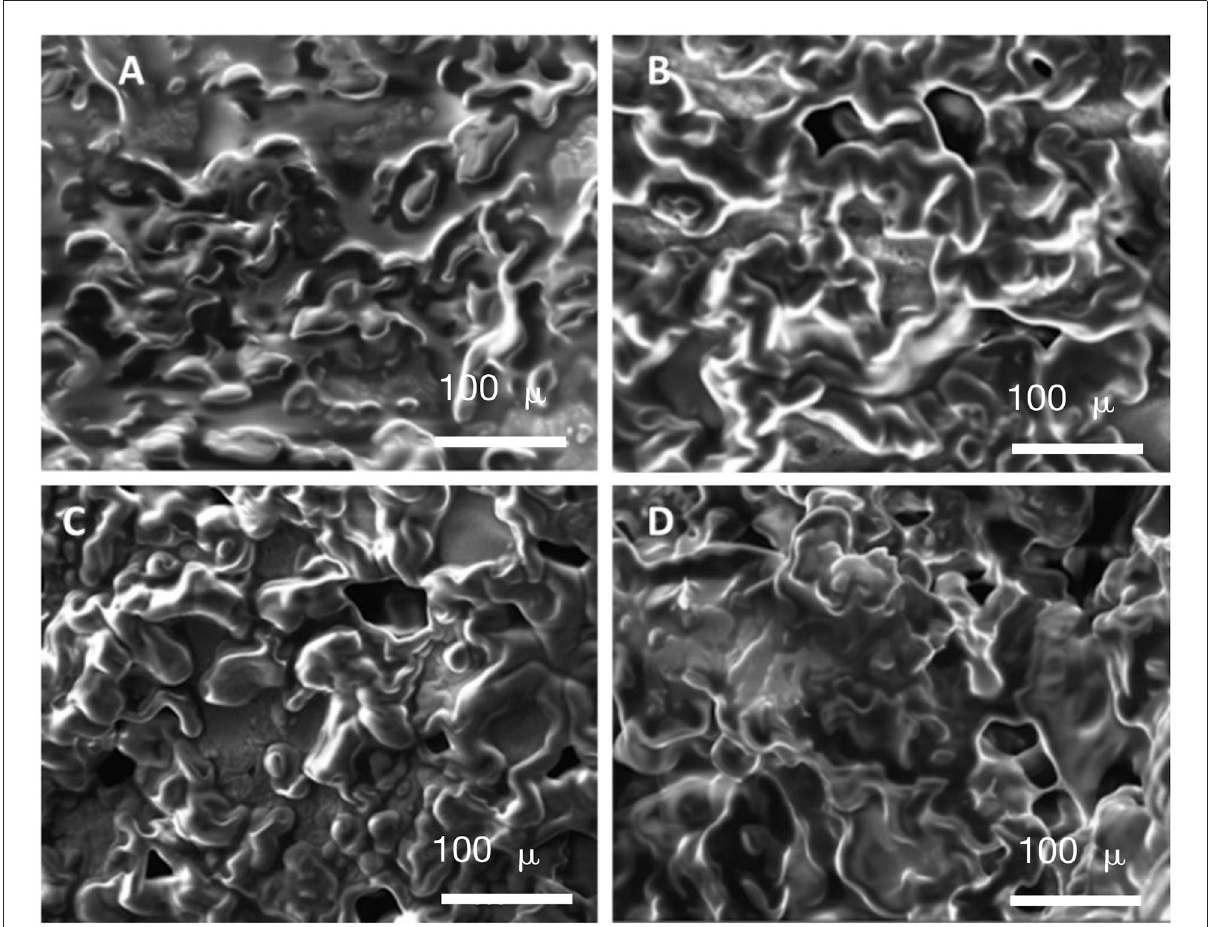
FIGURE4 The micro-structures of deep-fried donuts are produced using different processing methods. (A) Kombucha cellulose, (B) Kombucha cellulose produced via enzymatic treatment, (C) Kombucha cellulose produced via microwave-intensified treatment, and (D) Control (deep-fried donuts without cellulose) using a scanning electron microscope ( ×